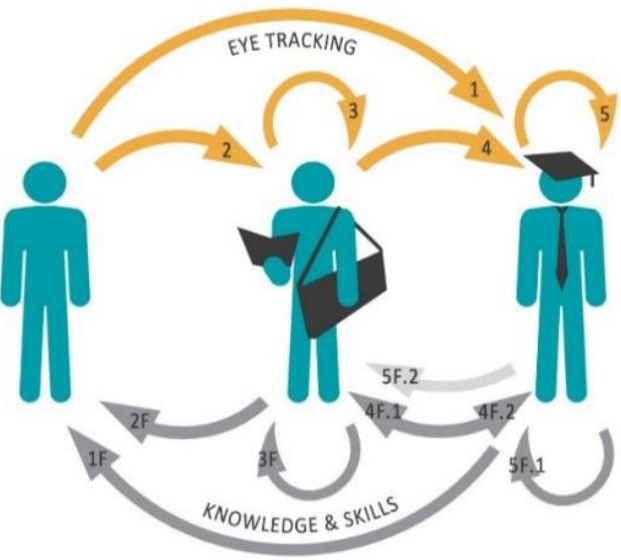
Figure 6. A graph presenting research-related relationships between the participants of eye tracking tests (by M. Rusnak and M. Rabiega).